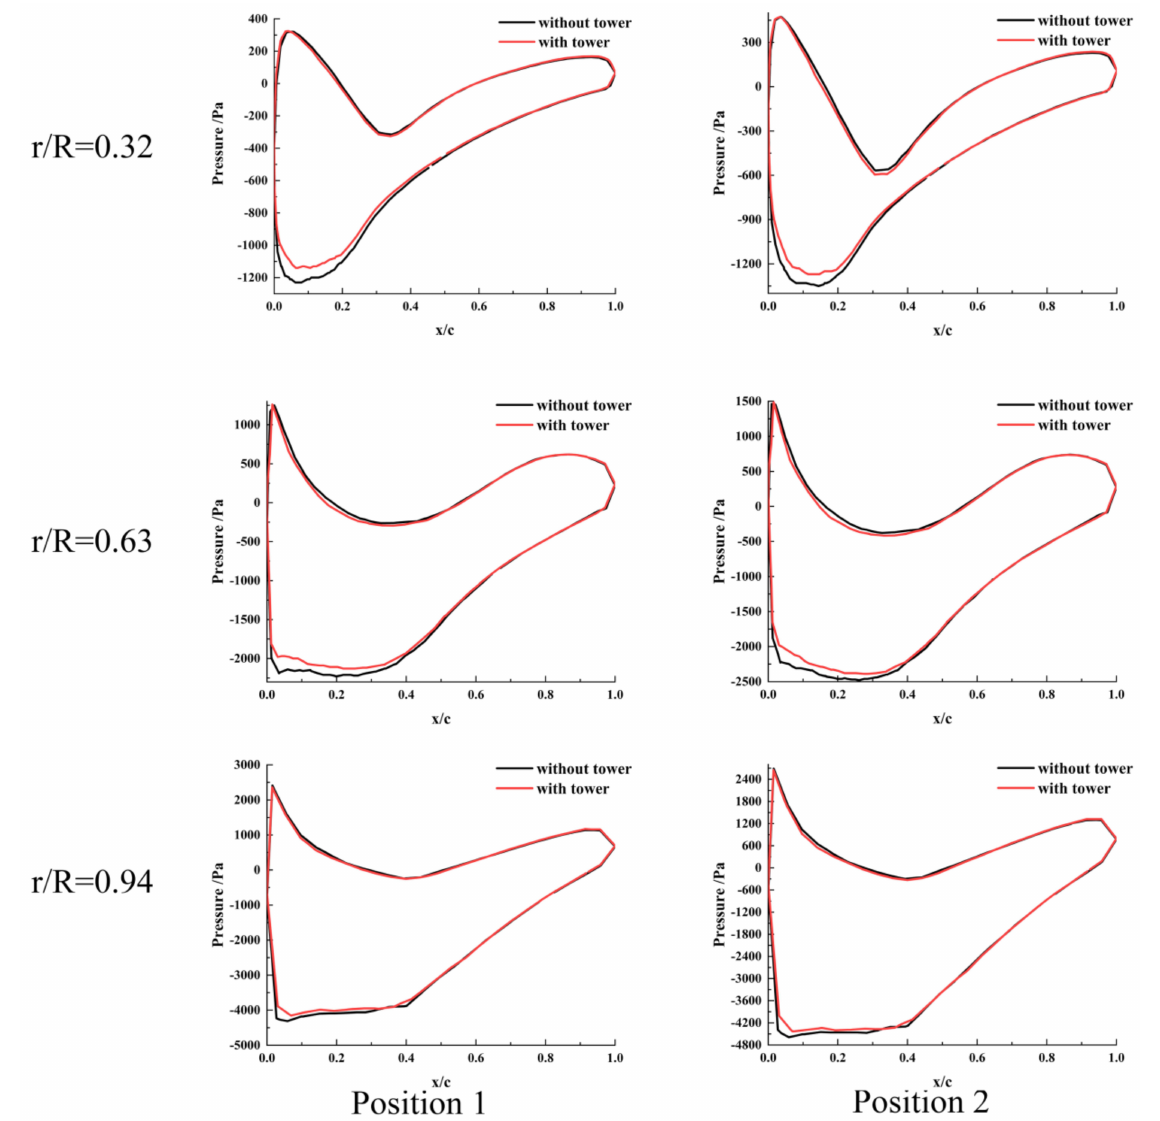
Figure 22. Distribution of pressure in each section of blade at position 1 and position